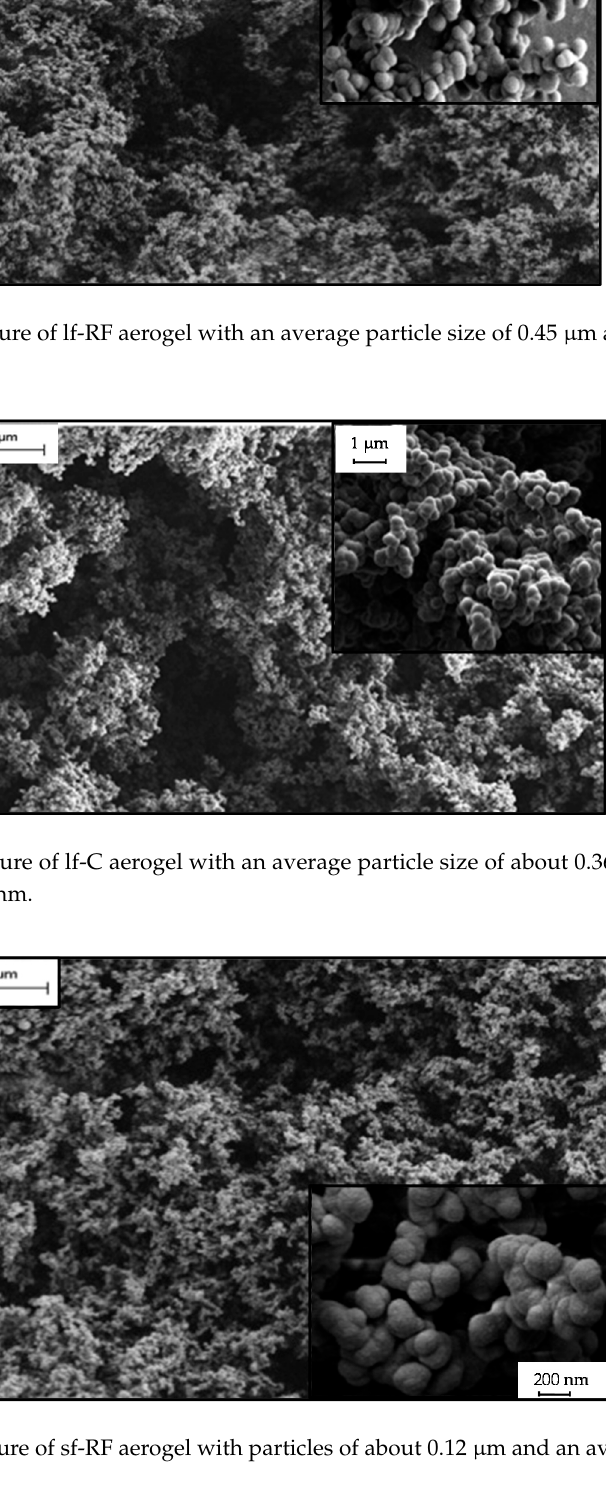
Figure 4. Microstructure of sf-C aerogel with an average particle size of 0.09 µm and an average pore size of about 104 nm. The mass loss Δ m during pyrolysis, which can be measured by thermogravimetric analysis (TGA), can be used to calculate the particle size of the carbonized aerogel. We assume that (cid:1865) (cid:3004) = (cid:1865) (cid:3019)(cid:3007) − ∆(cid:1865)